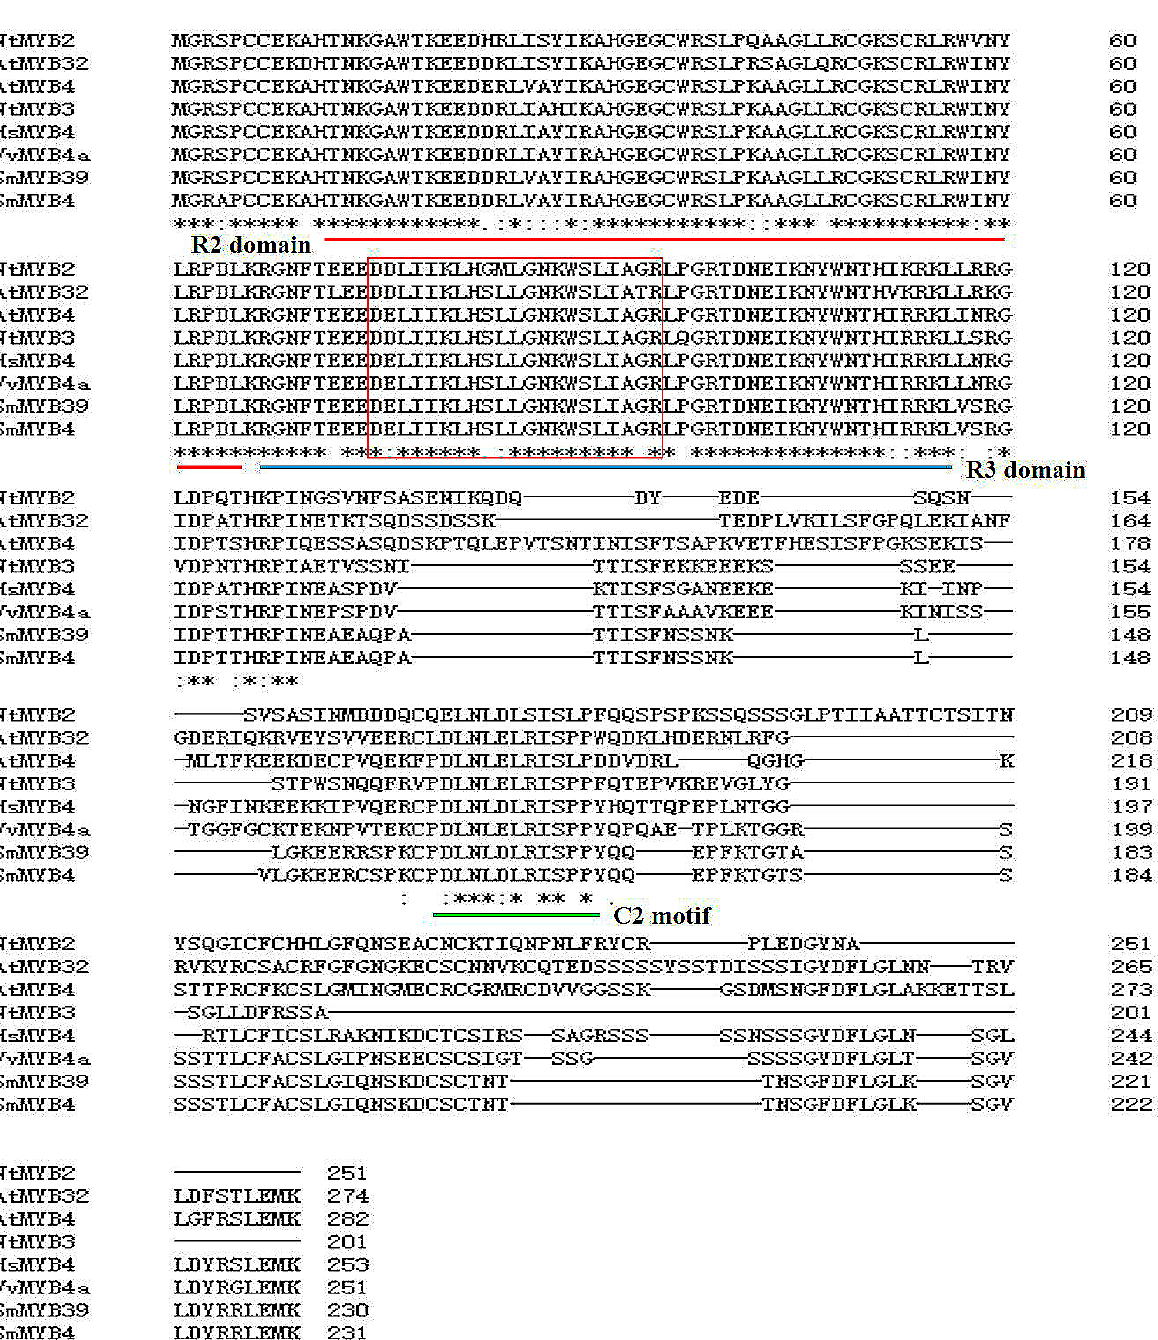
Figure 2. Multiple alignments of the amino acid sequences of SmMYB4 and other R2R3-MYB repressors belonging to subgroup 4. R2 domain, R3 domain, and C2 motif are marked in red, blue, and green lines, respectively. The bHLH binding motif is shown by the red rectangle (*, ** and *** Represents that they have the same conserved structure and function.).